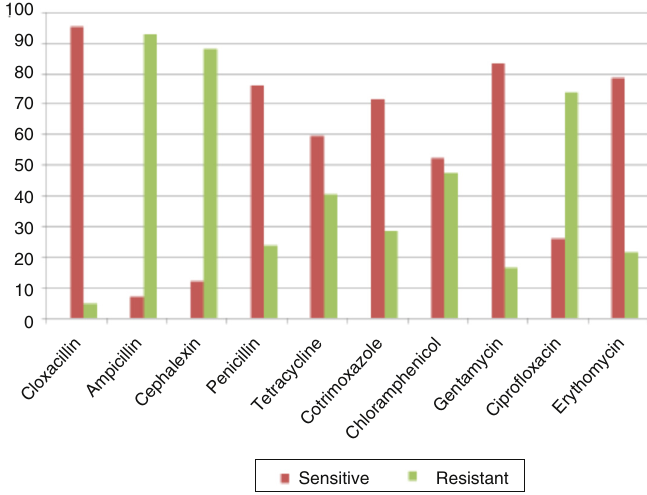
Figure 3 Antibiogram of S. aureus